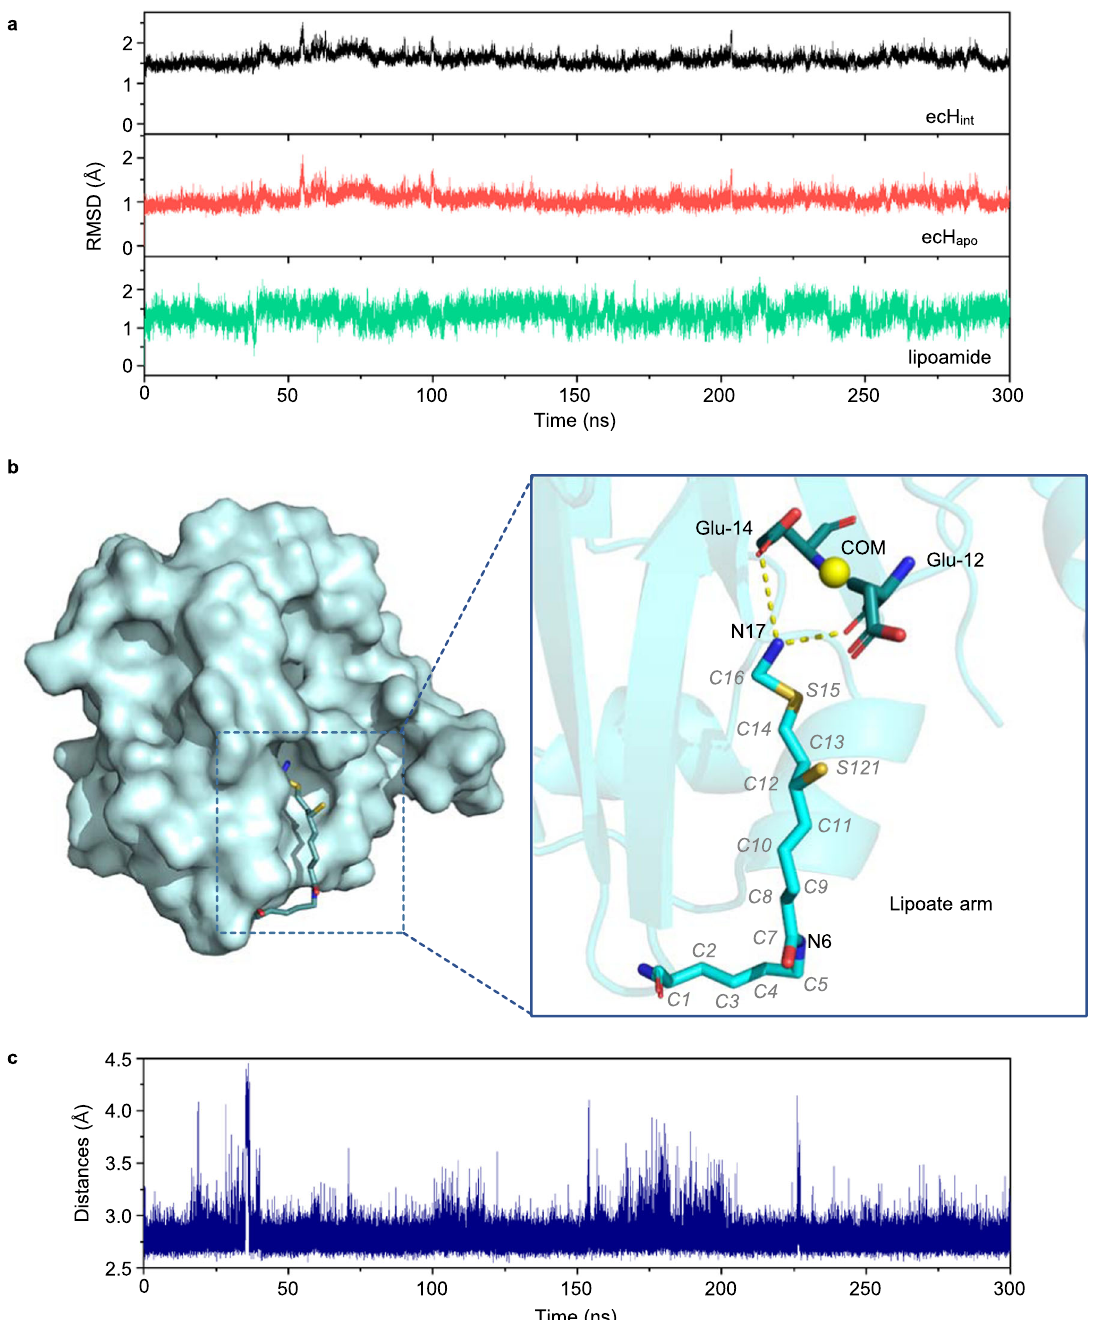
Fig. 2 Molecular dynamic simulations of protein H. a Root-mean-square deviations (RMSD) calculated for ecH int , ecH apo , and aminomethyl lipoate arm. b Hydrogen-bond interactions among the lipoate arm and the surrounding amino acid residues. N17 in the aminomethyl lipoate arm forms hydrogen bonds with Glu-12 and Glu-14 of protein H and renders thereby the aminomethyl lipoate arm in the cavity of protein H in a stable state. c Distance between N17 located in the aminomethyl lipoate arm and the COM of Glu-12 and